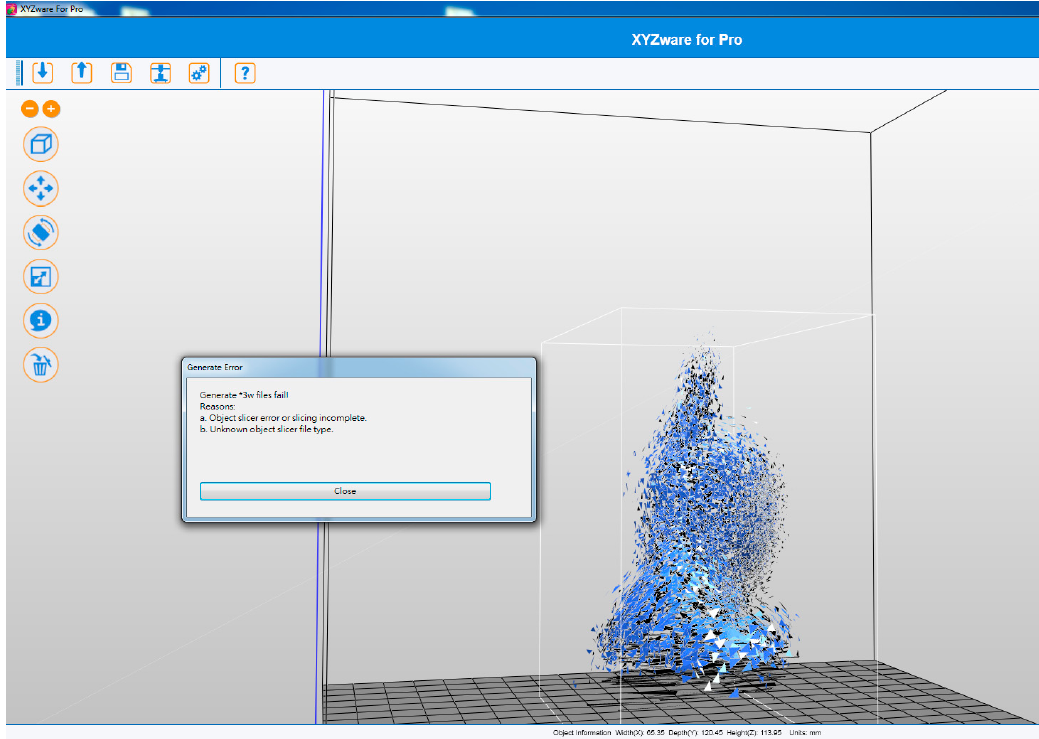
Figure 11. 3D printer cannot print the encrypted 2D slices.